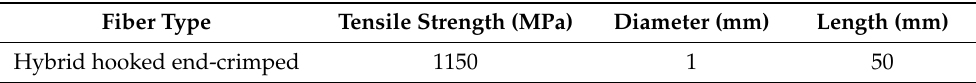
Table 2. Properties of used fibers in this study.